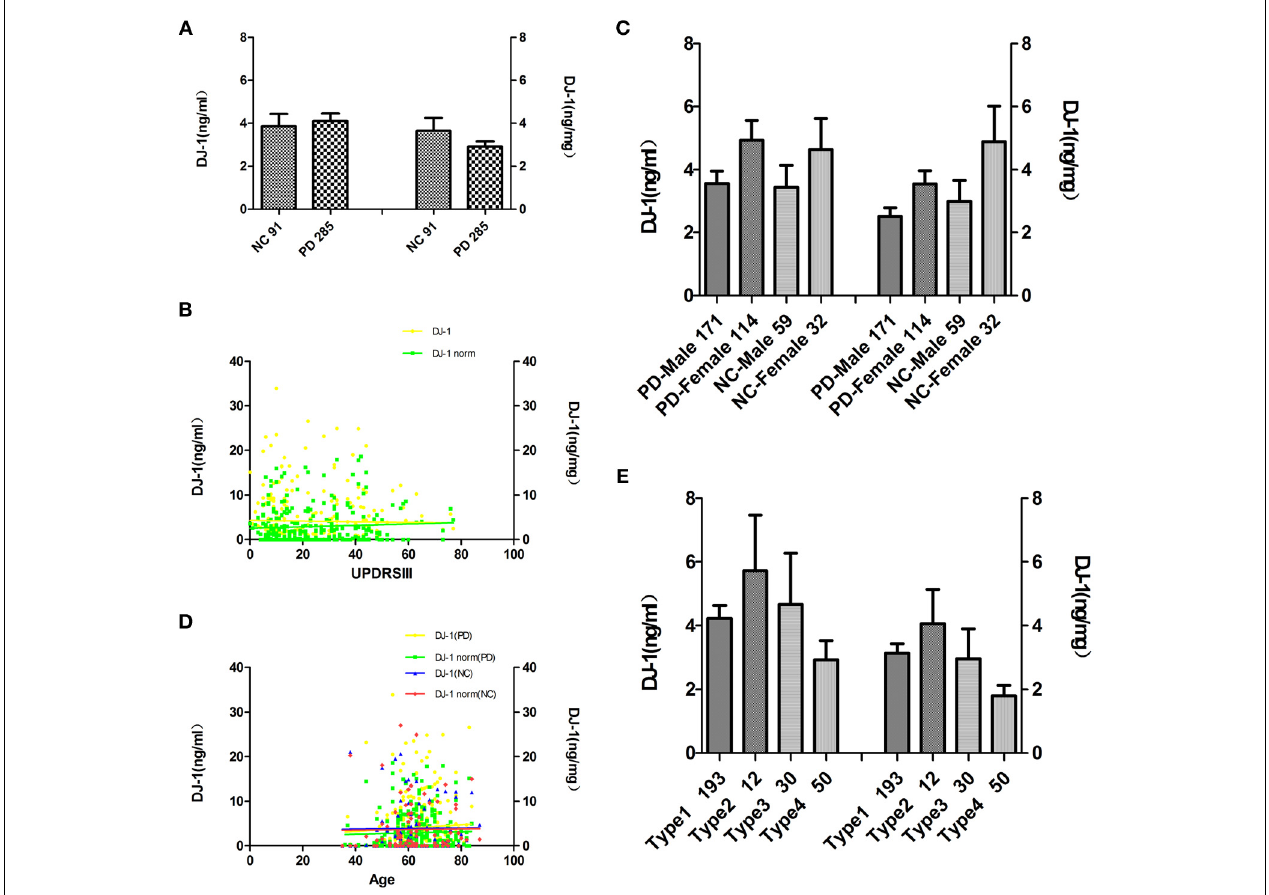
FIGURE 2 | Analysis of salivary DJ-1 in healthy controls and patients with PD in a large cohort. Salivary DJ-1 levels were measured in 91 individual NC and 285 PD samples by Luminex assay. (A) Quantitative Luminex analysis of salivary DJ-1 levels in patients with PD and NC by the non-parametric Mann-Whitney U -test, before and after controlling for potential contributions secondary to outliers (e.g., age, sex), and no significant differences were found ( p = 0 . 72, p = 0 . 84 when normalized). (B) Salivary DJ-1 correlated with disease severity as measured by UPDRS motor scores was analyzed by the non-parametric spearman’s correlation analysis, no statistically significance was achieved ( p = 0 . 92, R = 0 . 006; p = 0 . 44, R = 0 . 05 when normalized). (C)